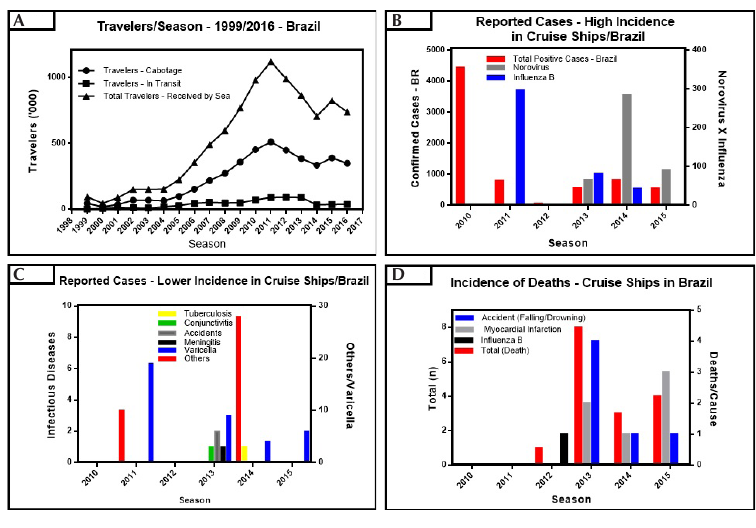
Figure 1. Morbidity and Mortality Rates -